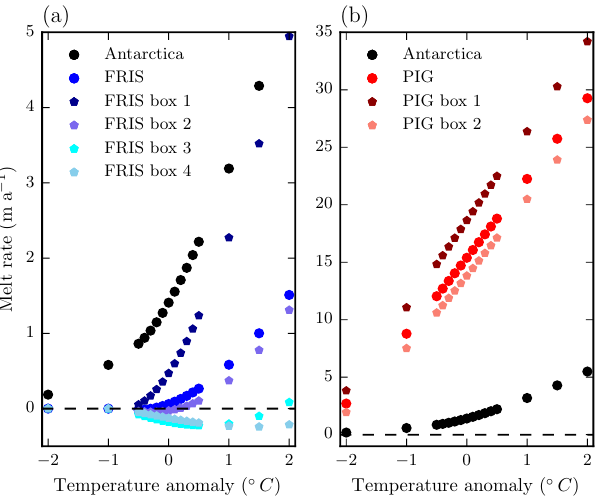
Figure 6. Sensitivity of PICO sub-shelf melt rates to ocean temper- ature changes for the entirety of Antarctica (black), Filchner-Ronne Ice Shelf (blue), and Pine Island Glacier Ice Shelf (red). Ocean input temperatures are varied by 0.1 up to 2 ◦ C. Melting depends quadrat- ically on temperature for “cold” cavities like the one adjacent to Filchner-Ronne, and linearly for “warm” cavities like the ones in the Amundsen